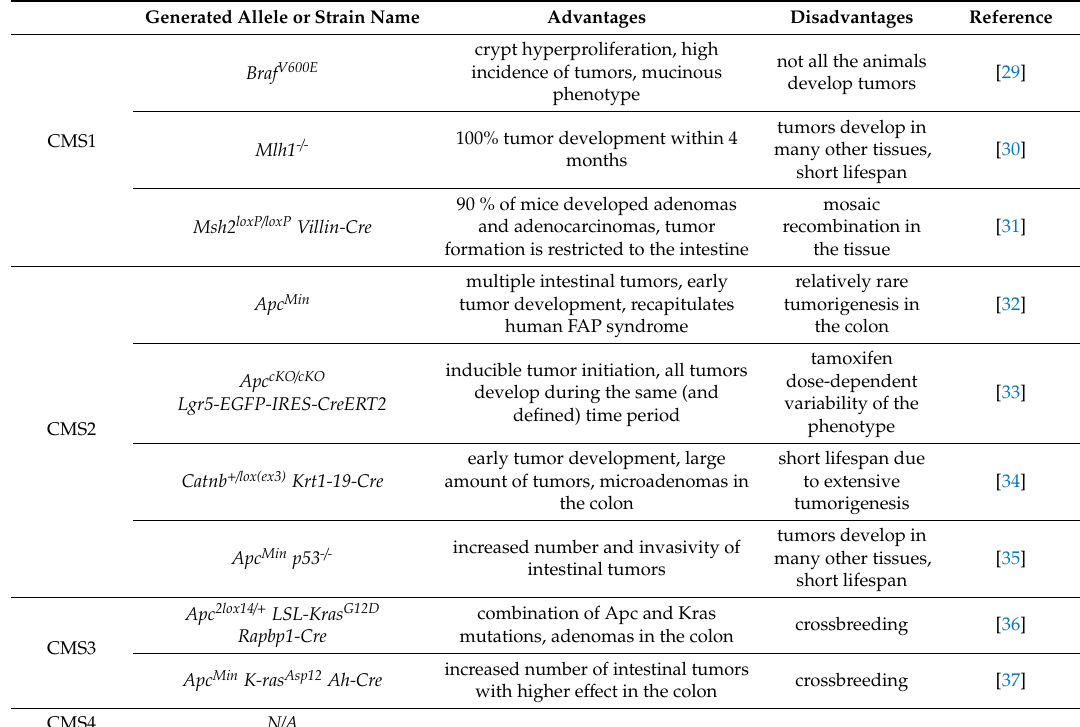
Table 2. Selected mouse models suitable for studying tumors belonging to the particular CMS group. Since CMS4 tumors are mainly characterized by activation of the transforming growth factor β (TGF β ) pathway in stromal cells, we did not include any mouse model to this category. It should be noted that mouse strains allowing downregulation of TGF β signaling are available. However, tumors developed in these mice fit well into the CMS2 group. N / A, not